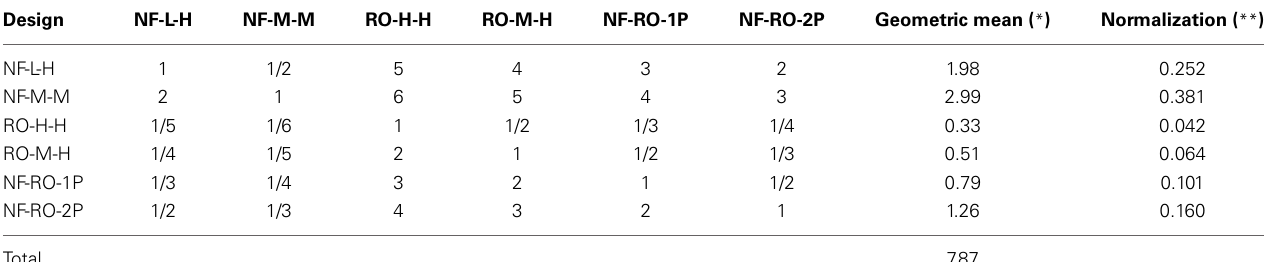
Table 5 | AHP pair-wise evaluation of min energy consumption (Number are based on Saaty’s Scale and an expert subjective point of